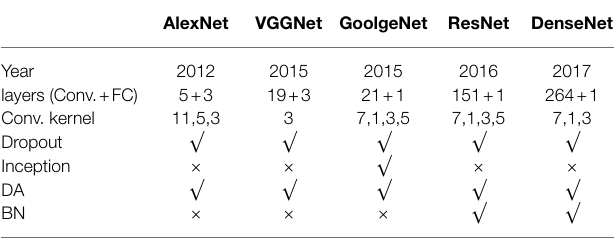
TABLE 2 | Comparisons of deep CNN models and its